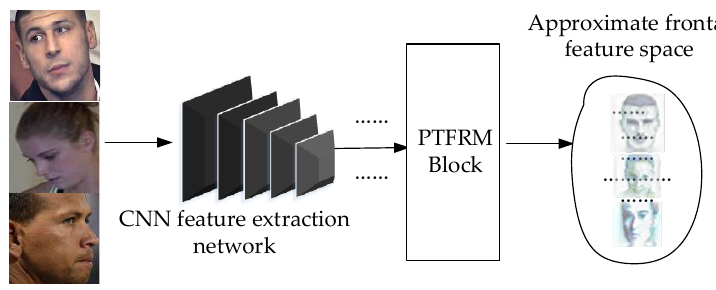
Figure 2. Transform multi-pose features to approximate frontal features.